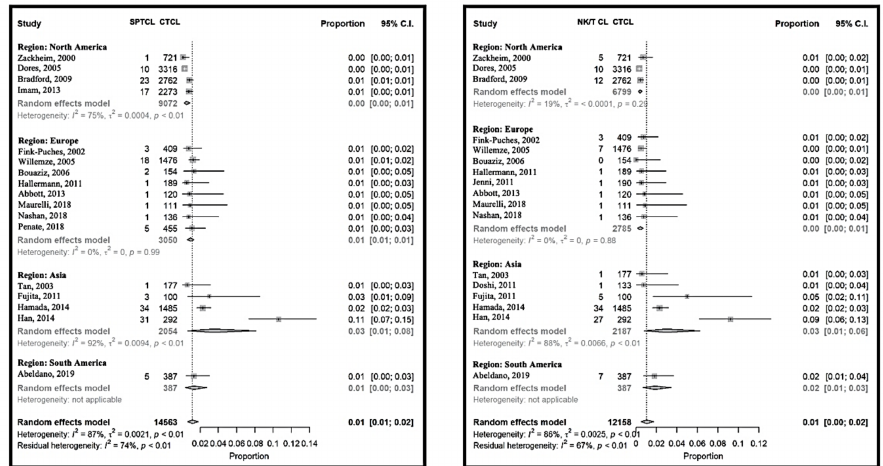
Figure 5. Meta-analyses of the proportion of rare CTCL, subcutaneous panniculitis-like T-cell lymphoma (SPCTL) and NK / T-cell lymphoma compared to